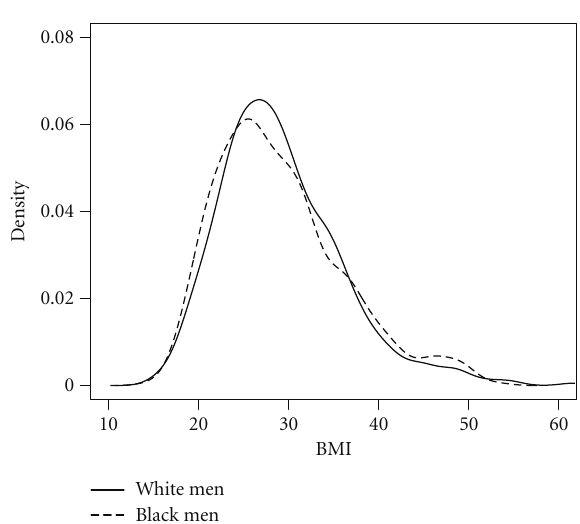
Figure 1: Probability density functions of body mass index for non-Hispanic Black and White men (1999–2006). Data from the National Health and Nutrition Examination